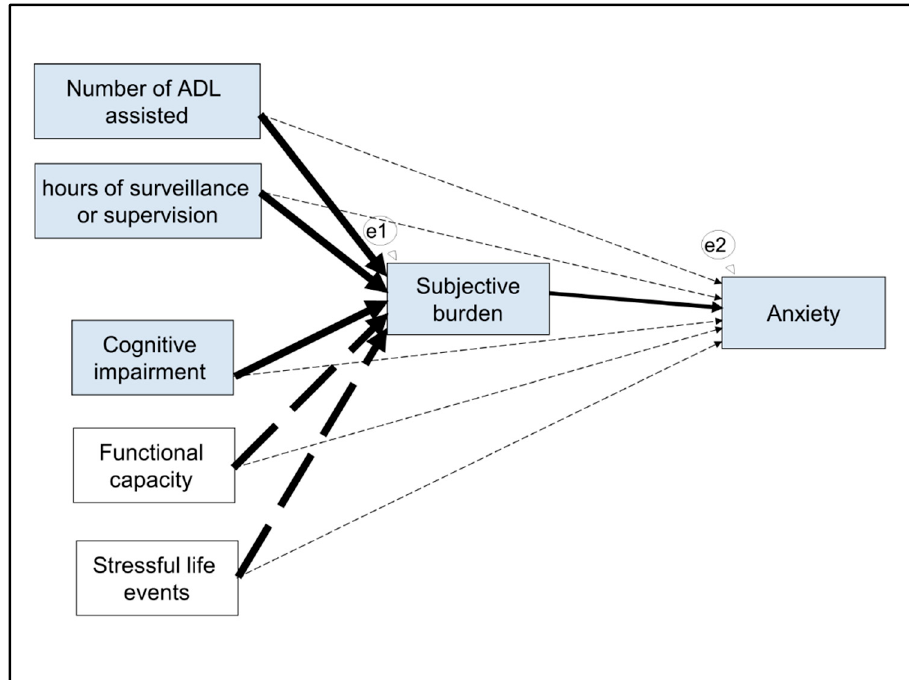
Figure 2. The starting model. Notes: e1 and e2 are latent errors. Arrows with a discontinuous line are non-significant pathways. Thin arrows correspond to relationships of hypothesis (1). Medium arrows correspond to relationships of hypothesis (2). Thick arrows correspond to relationships of hypothesis (3). Abbreviation: ADL, activities of daily living.